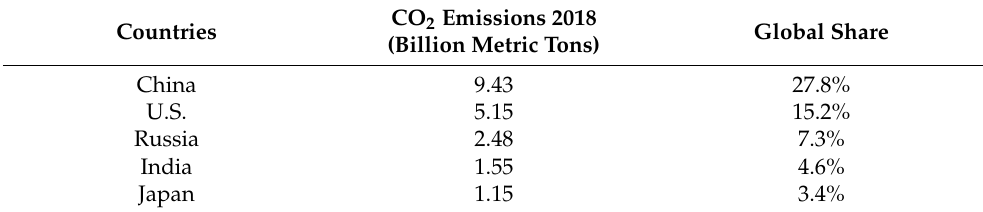
Table 17. Top 5 carbon-emitting countries, 2018. Countries